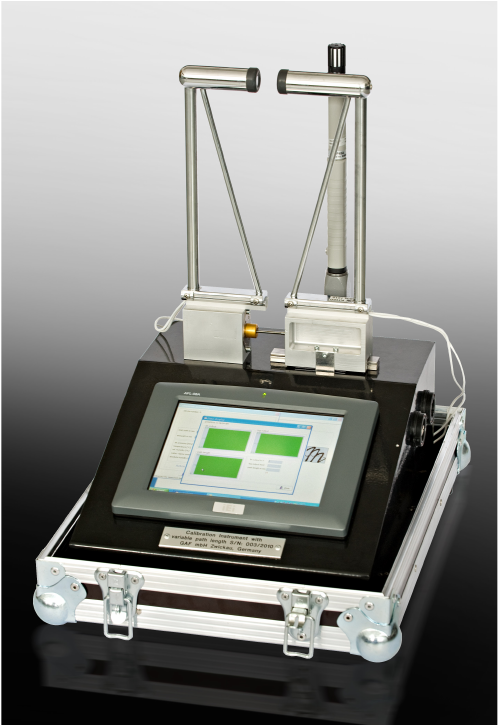
Fig. 3. Calibration system with krypton hygrometer, stepping mo- tor, HMP45A temperature-humidity sensor and touchpanel PC, the switch, fuses and connector for hygrometer at the left side and USB as well as network connector at the right side (photograph: B. Mast)